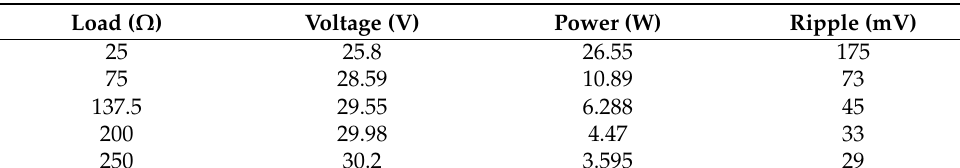
Table 3. Parameters during load change experiment.